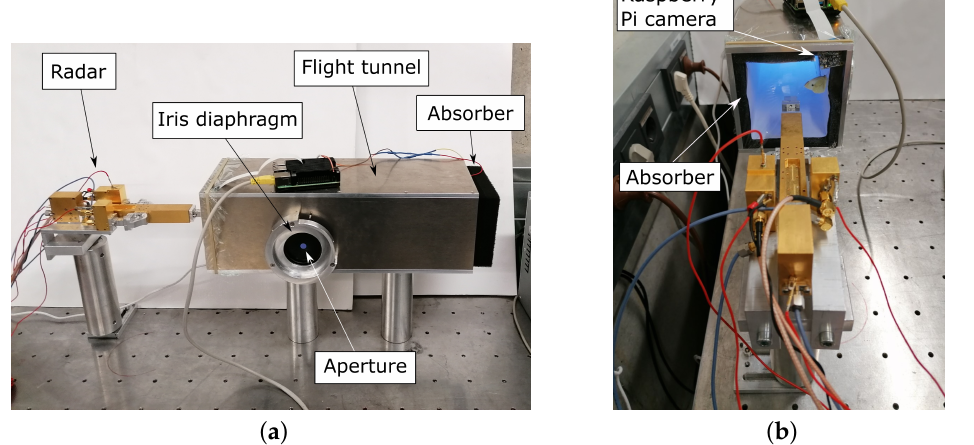
Figure 3. Experimental setup for bee measurements. ( a ) Side view. ( b ) Front